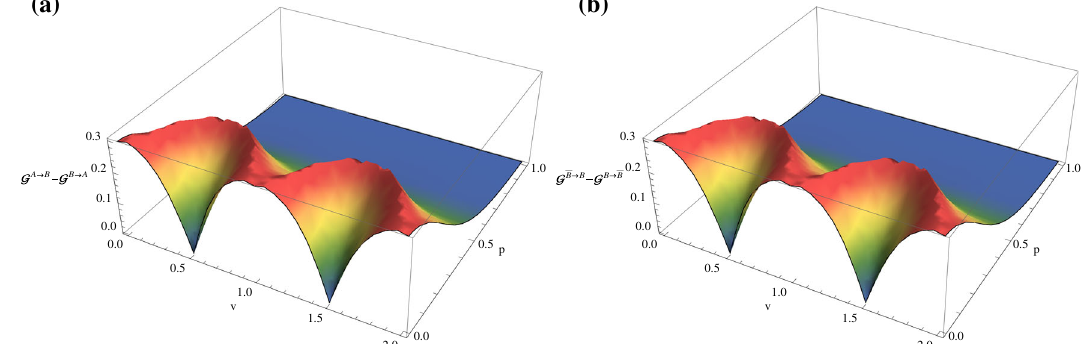
Fig. 3 The Gaussian quantum steerability G B → de Sitter space. The initial squeezing parameter is fixed as s = 0 . 5